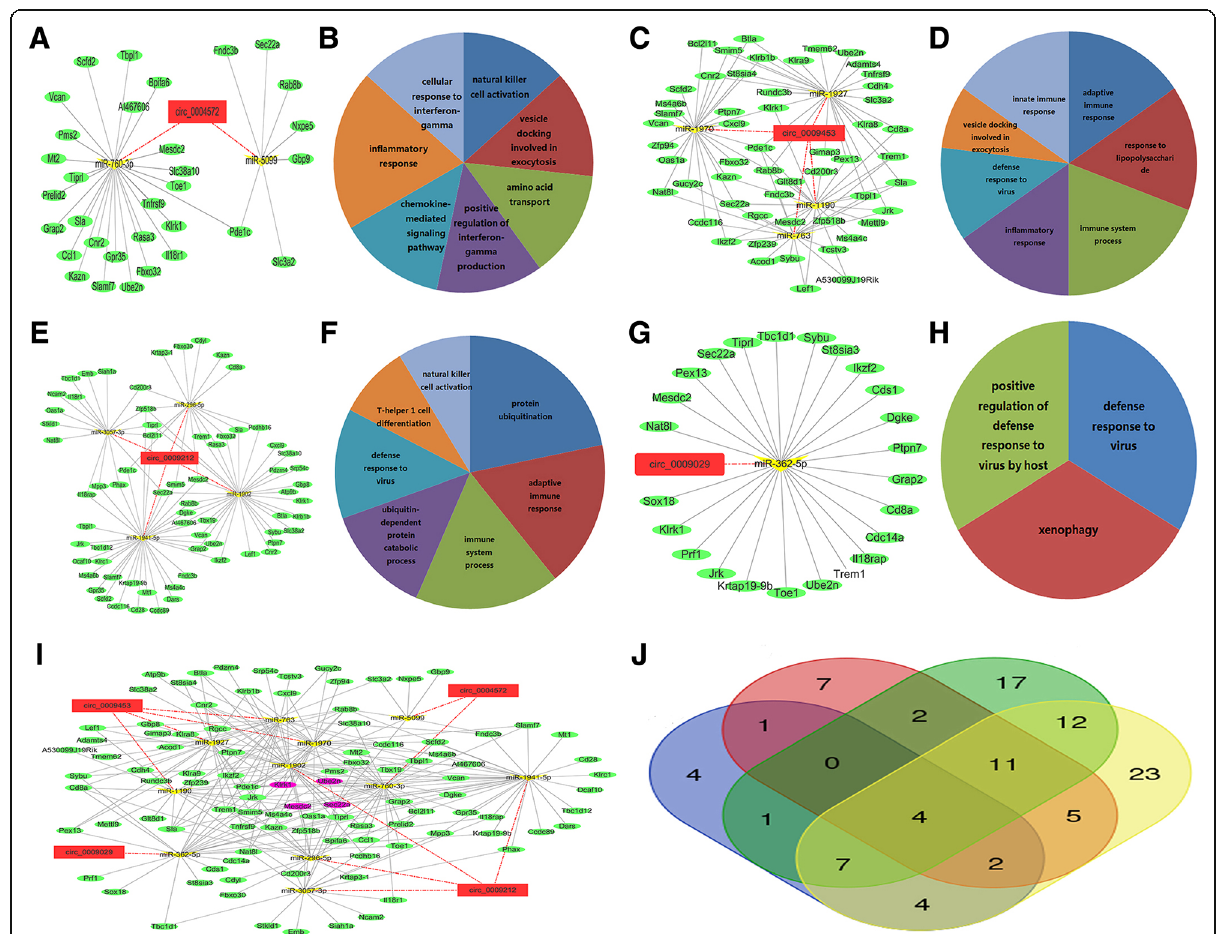
Fig. 6 CircRNA-associated ceRNA networks. Red rectangles represent circRNAs, green ellipses represent mRNAs, yellow triangles represent miRNAs, and pink nodes represent overlapped RNAs. a circ_0004572-associated ceRNA networks. b Enriched GO terms of mRNAs involved in circ_0004572 networks. c circ_0009453 associated ceRNA networks. d Enriched GO terms of mRNAs involved in circ_0009453 network ( e ) circ_0009212-associated ceRNA networks. f Enriched GO terms of mRNAs involved in circ_0009212 network. g circ_0009029-associated ceRNA networks. h Enriched GO terms of mRNAs involved in circ_0009029 network. i Merged ceRNA networks of four circRNAs. j Venn diagram of overlapped mRNAs among four circRNA- associated ceRNAs. Blue represents circ_0009029-associated mRNAs, red represents circ_0004572-associated mRNAs, green represents circ_0009453- associated mRNAs and yellow represents circ_0009212-associated mRNAs